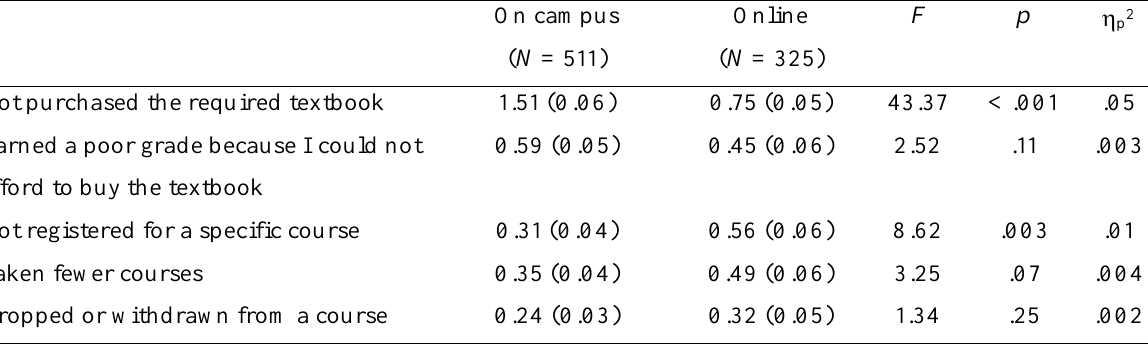
Comparisons of the Frequency of Engaging in Various Strategies to Offset Textbook Costs in Online Versus On-Campus